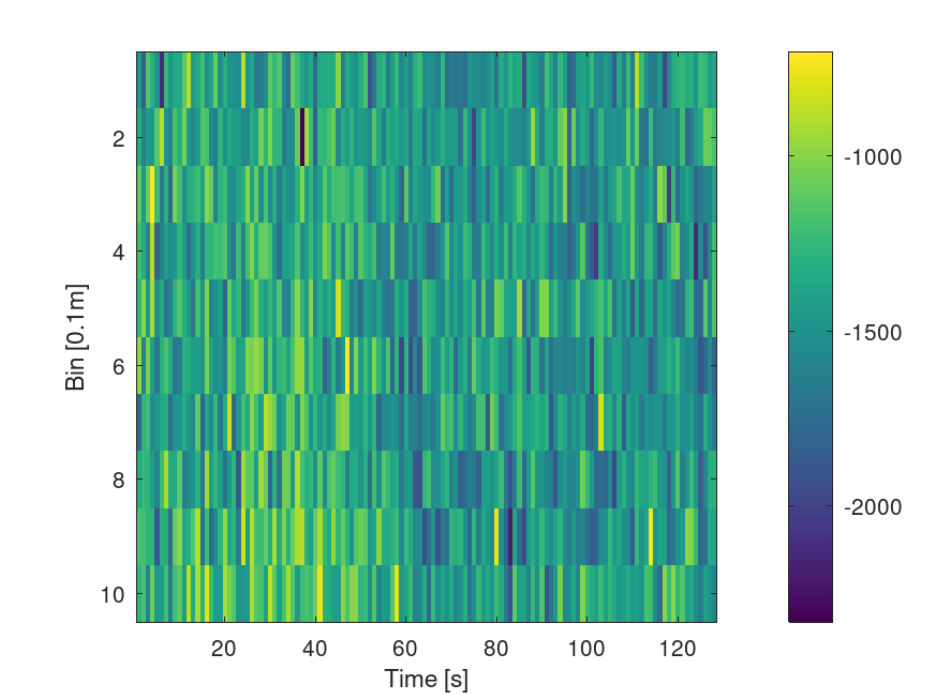
Figure A6. Waterfall plot of filtered inflow x–velocity for Aquadopp 2 in mm/s. Bin size is 0.1